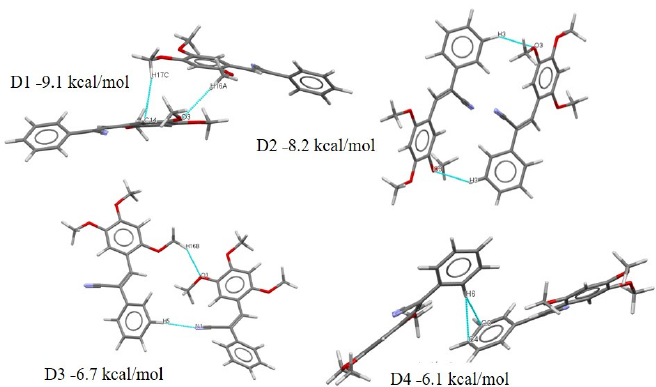
Figure 16. Different dimers (D1–D4) with interactions in the I crystal structure with respective interaction energies.